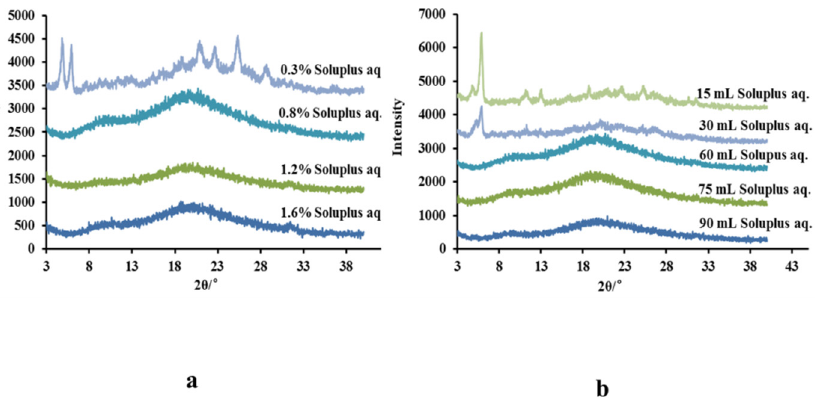
Figure 7. XRPD patterns of AINs prepared with different volumes of soluplus aqueous solutions ( a ) and different soluplus concentrations ( b ). AINs: amorphous icaritin nanoparticles; XRPD: X-ray powder diffraction.